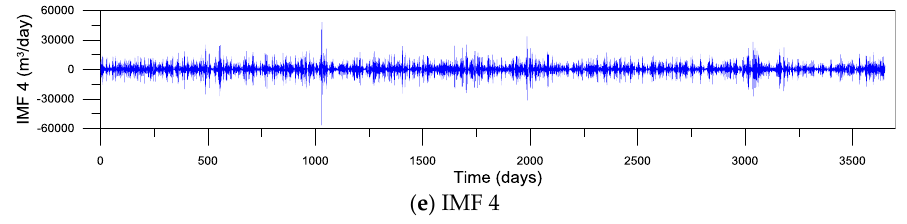
Figure 6. Water demand time series and IMFs.